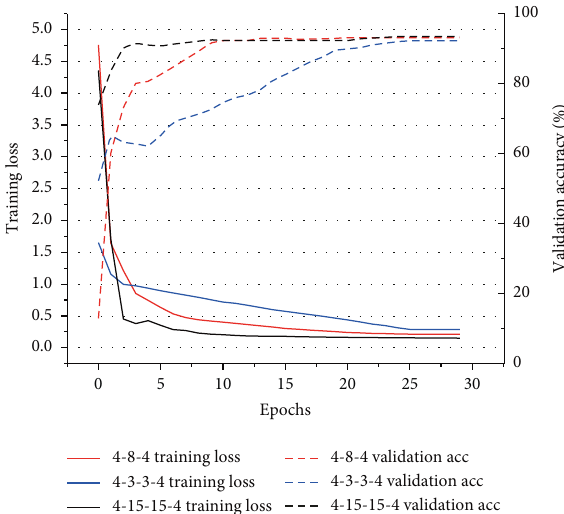
Figure 11: The training loss